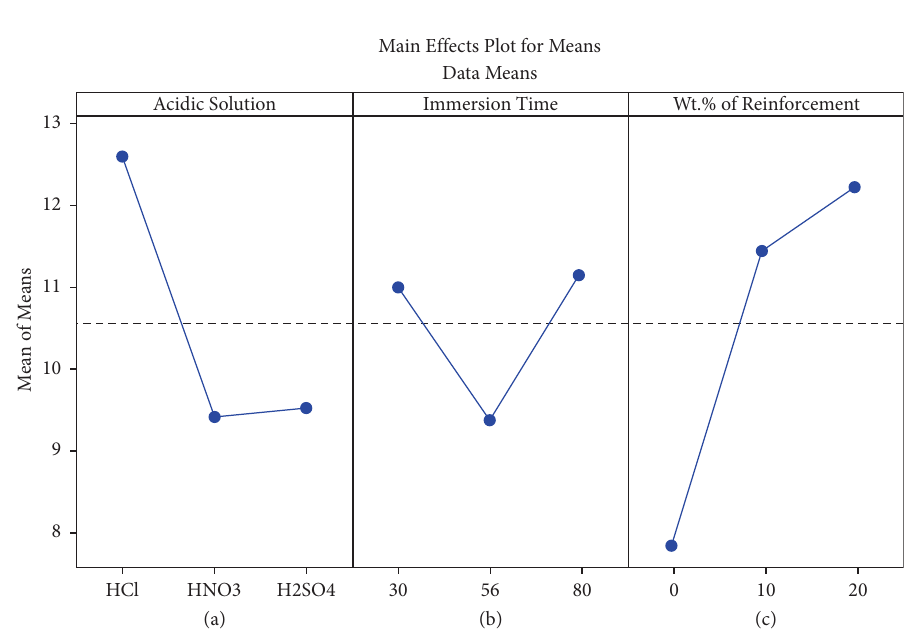
Figure 8: Plot showing the mean efect of